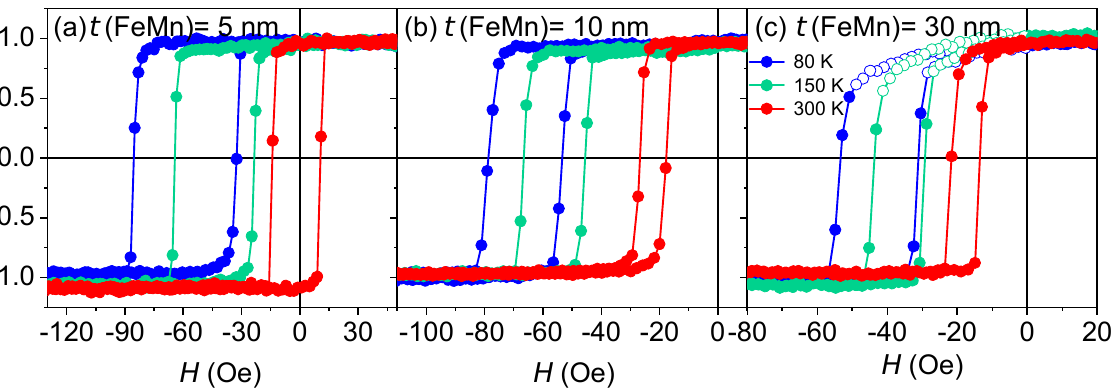
Figure 10. Hysteresis loops measured at 80 K, 150 K, and 300 K for the samples NiFe (47 nm)/FeMn ( t nm) deposited at room temperature of the substrate. The thicknesses of the FeMn layer are: ( a ) 5 nm; ( b ) 10 nm; ( c ) 30 nm.